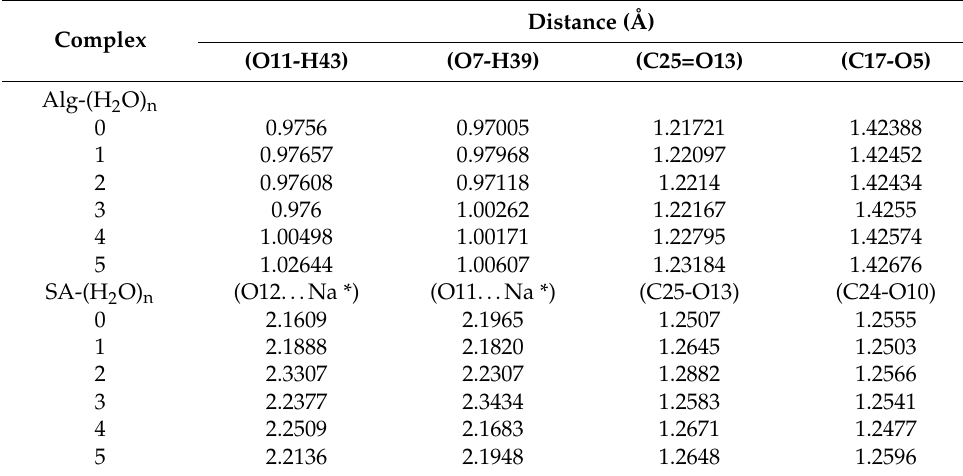
Table 2. Bond length detail of alginate and alginate-(H 2 O) n complexes.